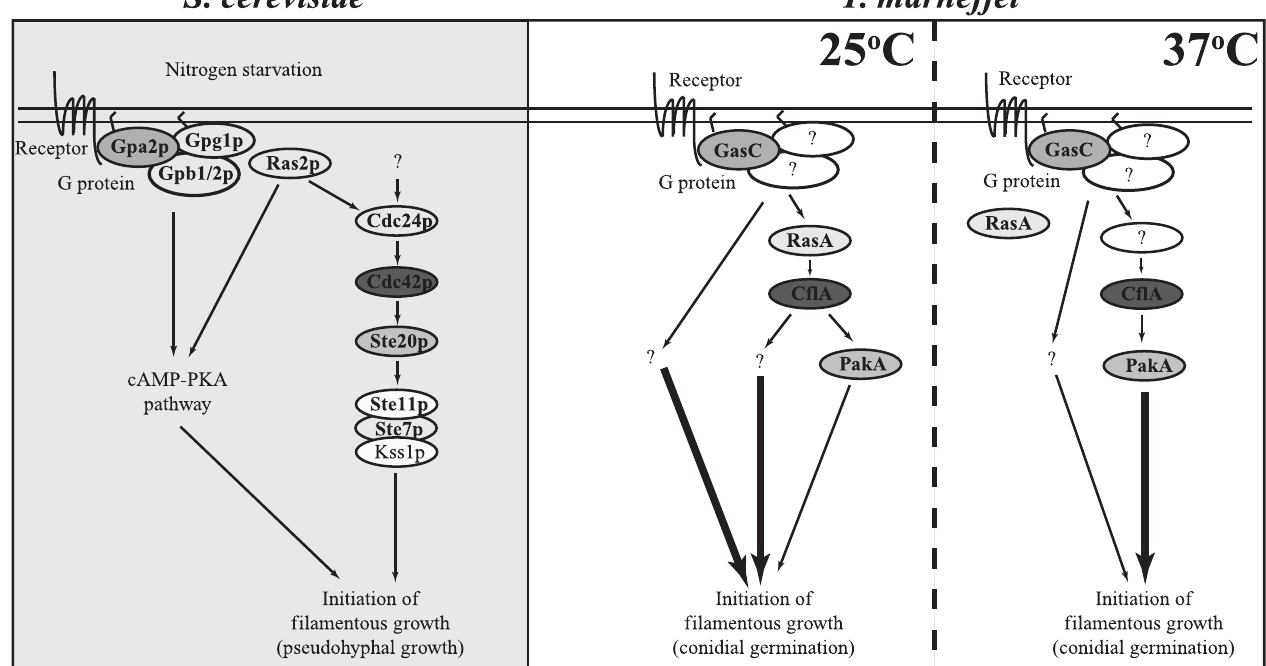
Figure 8. Models for the Regulation of the Initiation of Filamentous Growth in S. cerevisiae and P. marneffei (A) In S. cerevisiae , nitrogen starvation triggers a switch from the unicellular budding growth form to a filamentous growth form (pseudohyphal growth). The activated GTPase Ras2p, activates the GEF Cdc24p, which catalyses the activation of the Rho GTPase Cdc42p. Cdc42p activates the PAK kinase Ste20p, which leads to the activation of a MAPK kinase cascade, which culminates in the activation of the transcription factor Ste12p. The activation of a heterotrimeric G protein is also involved in the initiation of filamentous growth in S. cerevisiae, via activation of cAMP signaling. (B) In P. marneffei , GasC (Gpa2p homologue) activates two pathways regulating conidial germination at 25 8 C. In one pathway, GasC activates RasA (Ras2p homologue), which activates CflA (Cdc42p homologue). CflA activates PakA (Ste20p homologue) via the CRIB domain and this interaction is required for PakA function. CflA also activates an additional unknown effector at 25 8 C, which plays a more important role than PakA in germination. It is possible that GasC directly acts on PakA and does not act upstream of RasA and CflA. B. At 37 8 C, GasC also activates two pathways regulating conidial germination. In one pathway, GasC activates CflA, which activates PakA. Similar to 25 8 C, at 37 8 C CflA activates PakA via the CRIB domain and this interaction is required for PakA function. Unlike 25 8 C, at 37 8 C RasA is not required for germination, PakA plays a crucial role during the establishment of polarised arthroconidiating hyphal growth, and no additional effector is required.